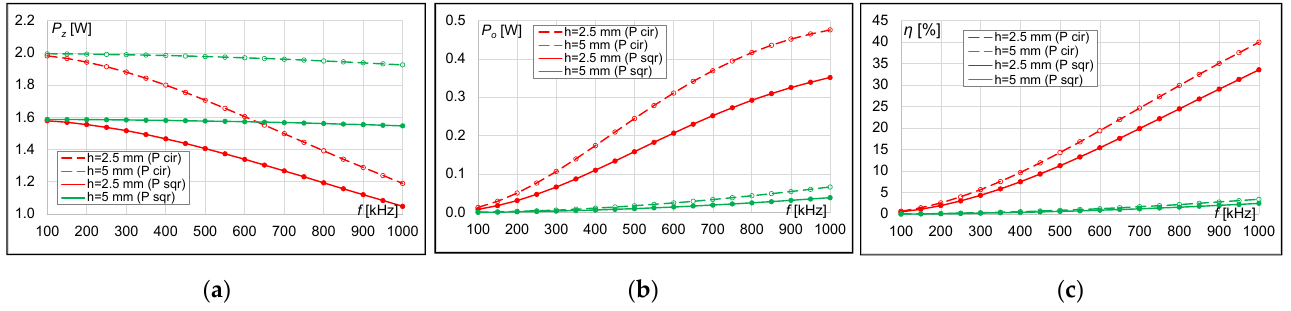
Figure 20. Results for the periodic system with circular or square coils with r = 5 mm and the number of turns n = 25 at two distances ( h = 2.5 mm and h = 5 mm): ( a ) transmitter power, ( b ) receiver power, ( c ) power transfer efficiency.